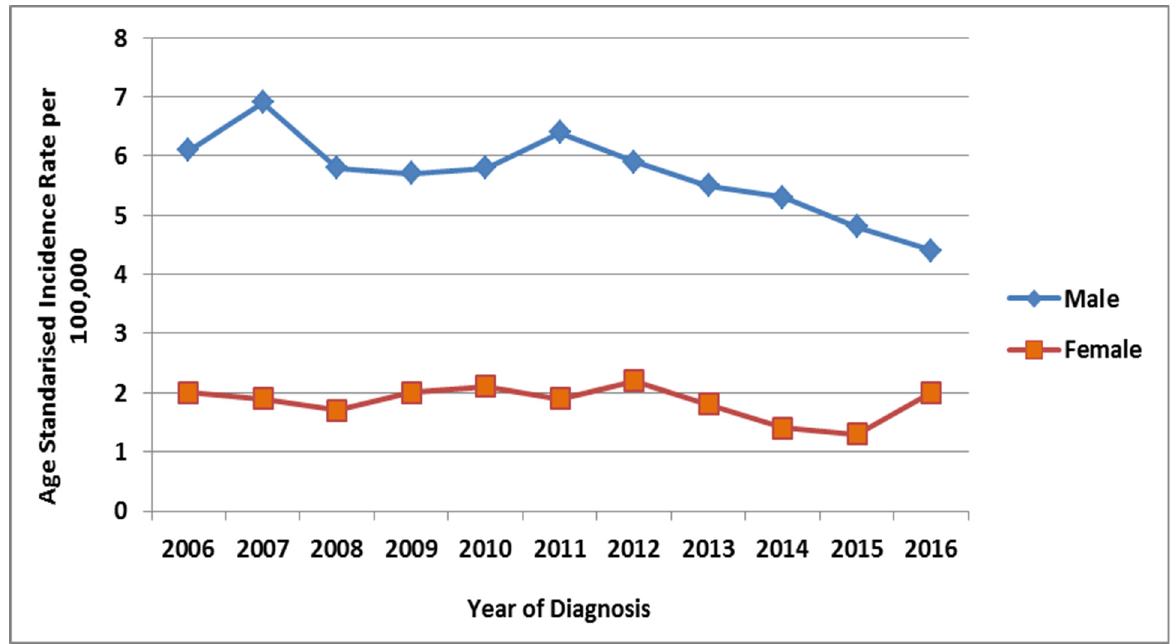
Figure 6. Age-standardized incidence rate of lung cancer per 100,000 in Saudi males and females.